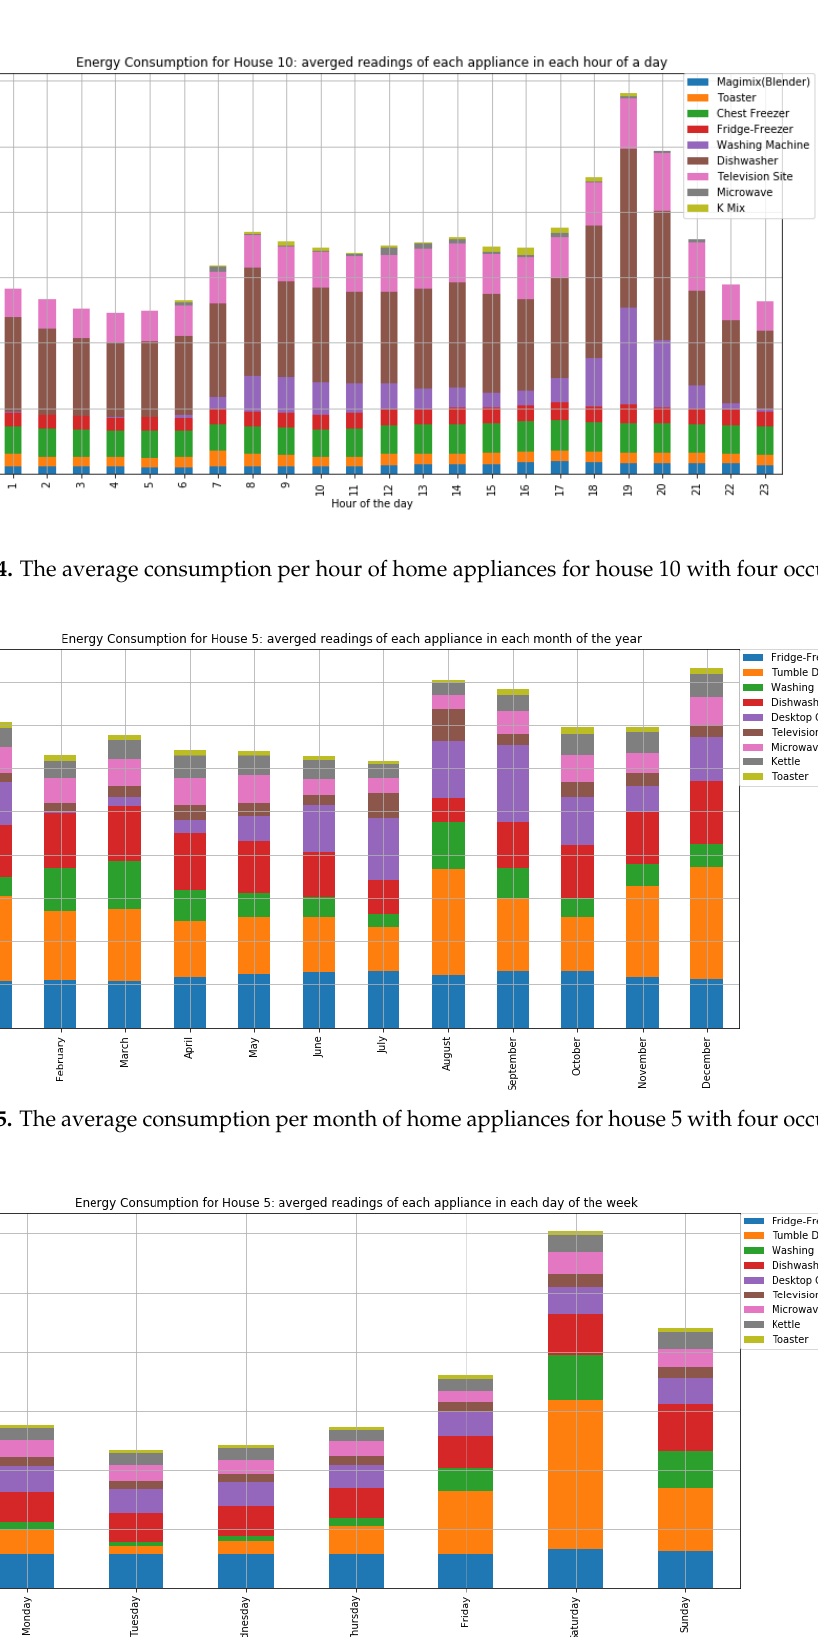
Figure A6. The average consumption per day of home appliances for house 5 with four